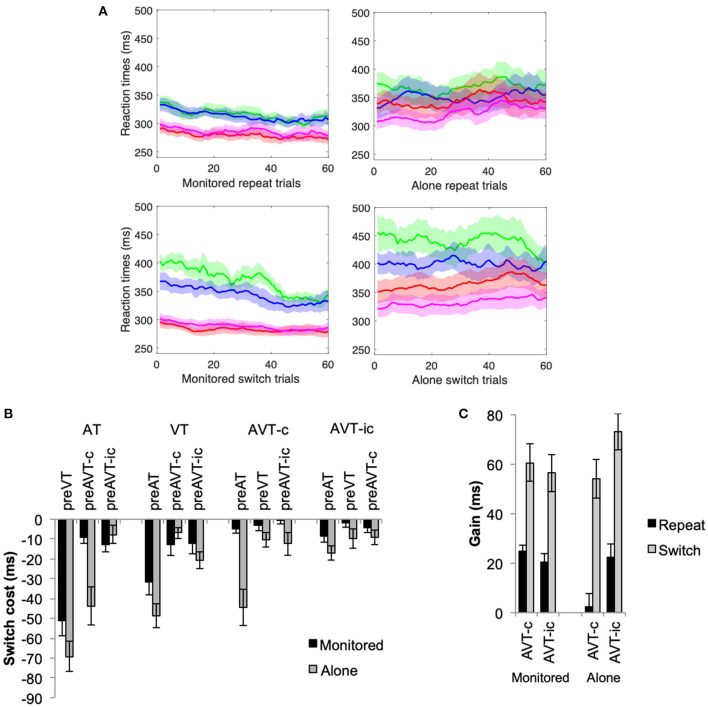
Experiment 2 (A) Moving averages of RTs (1 step of 10 trials) for the repeat and switch conditions for the AT (green), VT (blue), AVT-c (red), and AVT-ic (magenta) stimuli. (B) Mean switch costs = repeat—switch condition (+SEM), and (C) mean MS gain (+SEM) for stimuli, switch, and monitoring conditions.